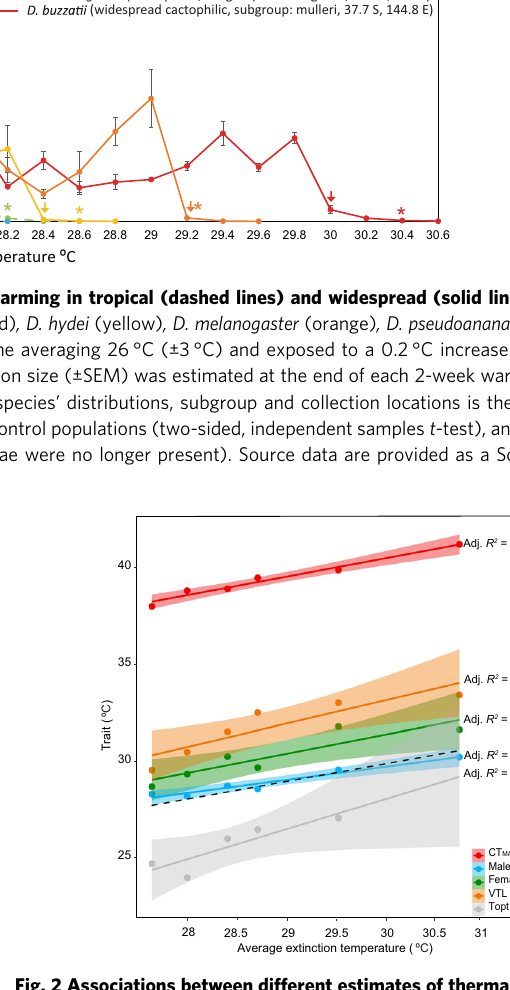
Fig. 2 Associations between different estimates of thermal tolerance and average extinction temperature across six Drosophila species. Critical thermal maximum (knockdown CTmax, red), male upper fertility thermal limits (male FTL 50 , blue), female upper fertility thermal limits (female FTL 50 , green), upper egg-to-adult viability thermal limits (VTL 80 , orange) and optimum thermal temperature ( T opt, grey) all show signi fi cant positive linear associations with average extinction temperature. Each point represents thermal tolerance for each species (see Supplementary Table S9 for values), the solid lines represent the fi tted linear model and the shaded areas are the 95% con fi dence interval of this model. The dashed black line represents the direct relationship (slope = 1) between tolerance and average extinction temperature. Male FTLs are the only estimate of thermal tolerance that does not signi fi cantly differ from extinction temperature (two-sided paired t -test, t = 0.738, df = 5, P =